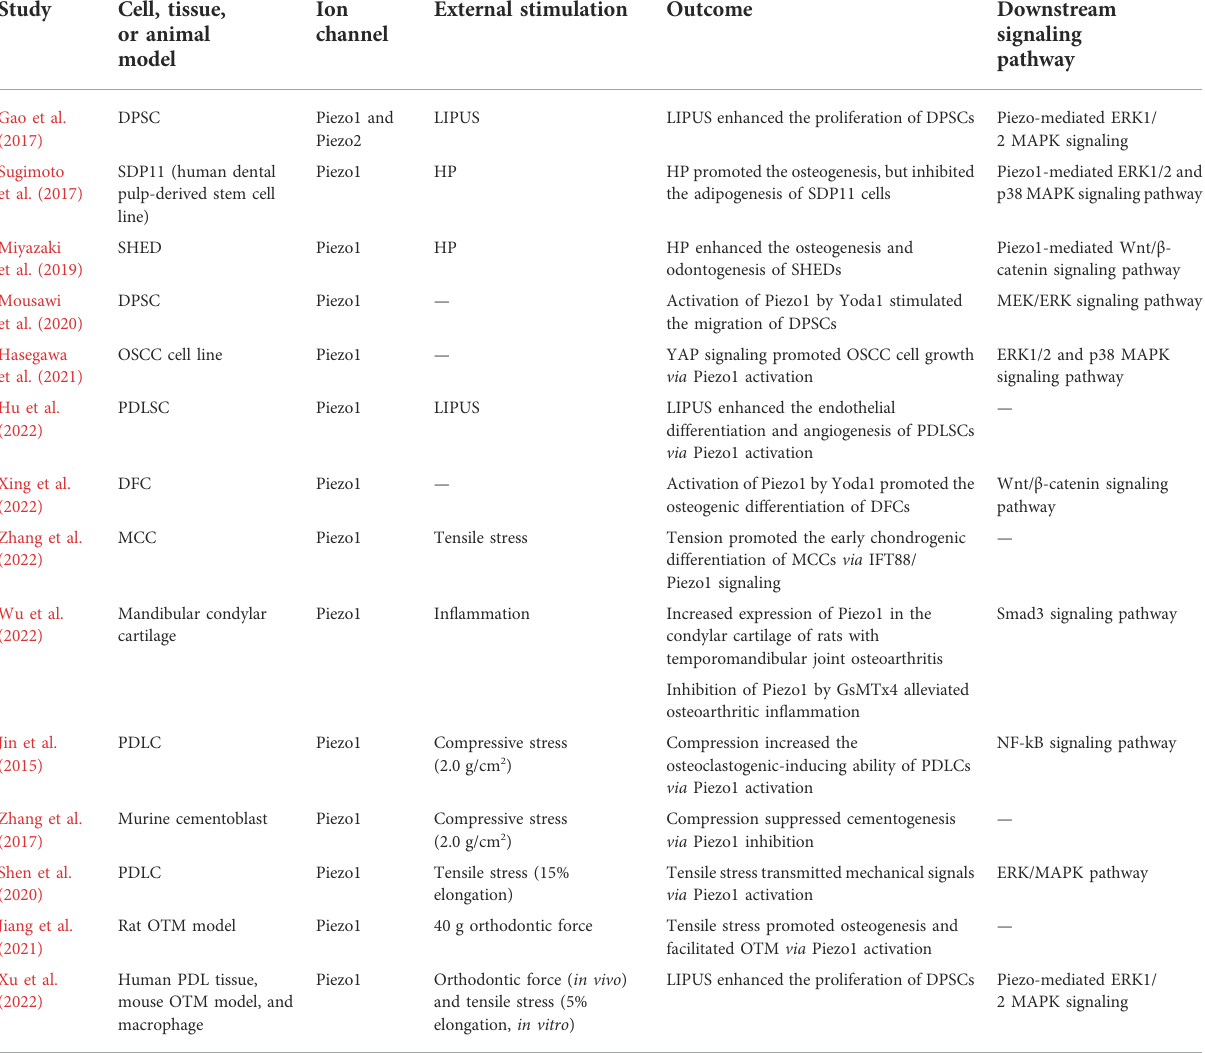
TABLE 2 The functional roles of Piezo ion channels in dental-derived cells and tissue. Study Cell, tissue, or